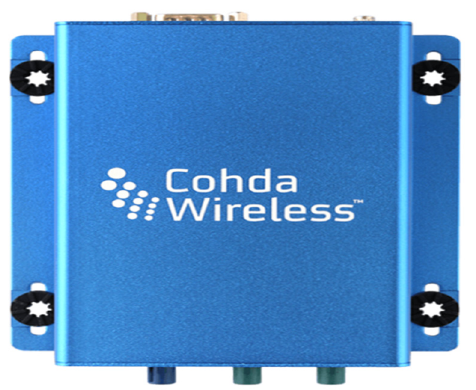
Figure 9. Communication module MK5 (OBU).